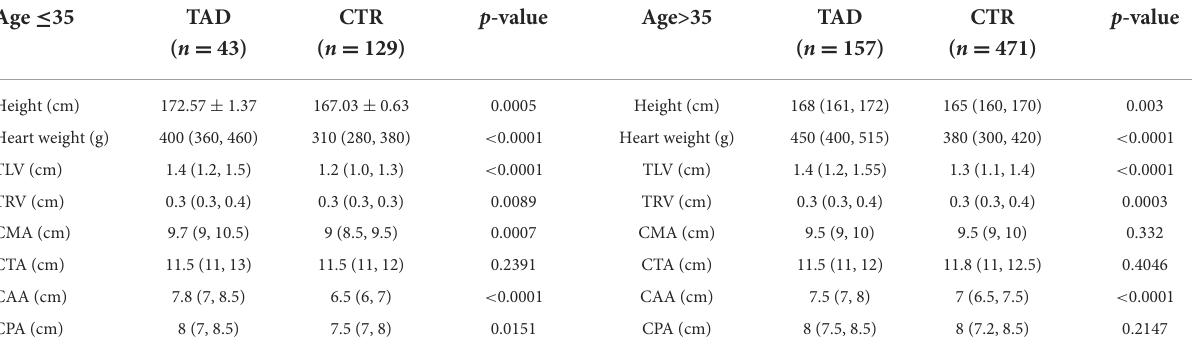
TABLE 5 Differences of postmortem findings between different age groups and their control